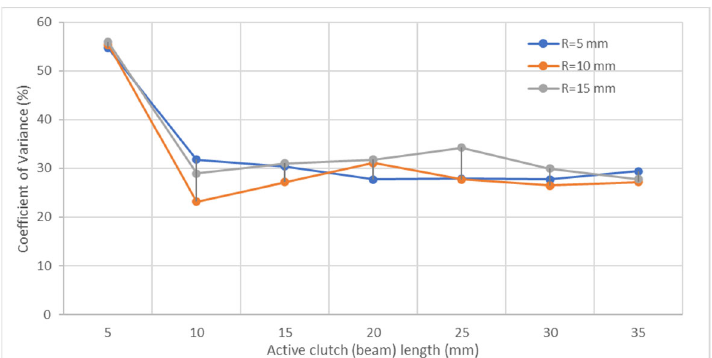
Figure 6. Coefficient of variance in analytical, numerical and experimental torsional stiffness value.